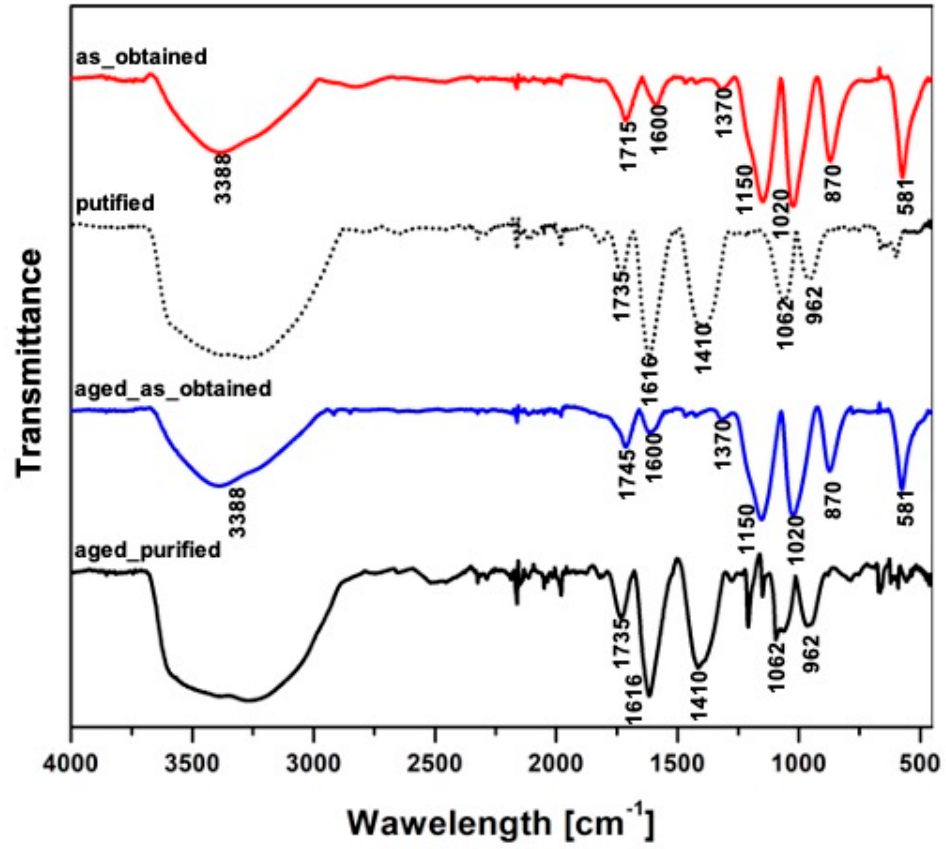
Figure 5. FTIR spectra of the as-obtained, aged_as-obtained, purified and aged_purified samples.